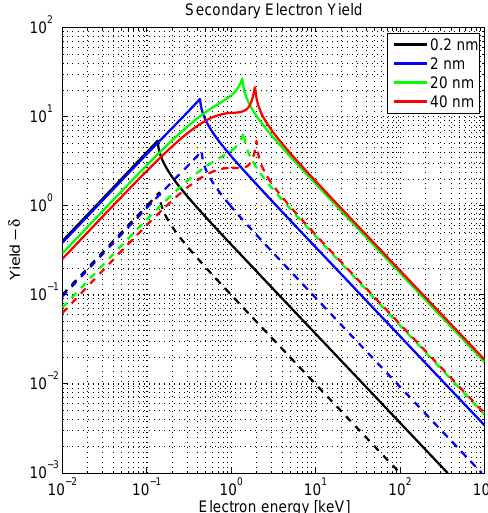
Figure 2. Secondary electron yield as a function of primary electron energy for metallic (dashed lines) and isolator (solid lines) particles of different